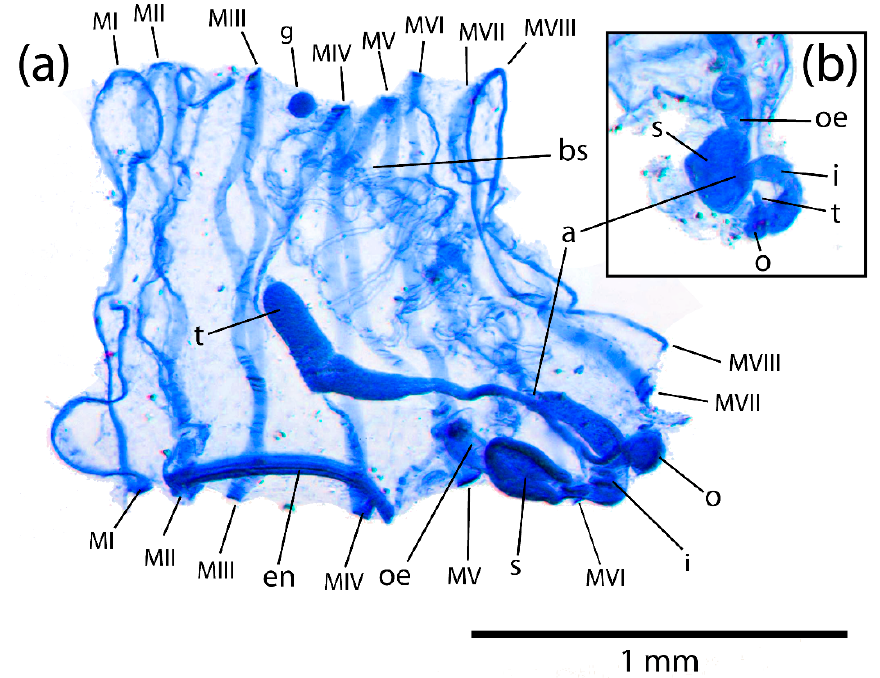
Figure 5. ( a ) Photograph of Janus Green B stained holotype of Dolioletta advena sp. nov. ( b ) Dorsal view of unrelated Janus Green B stained individual of D. advena sp. nov. which was dissected so that digestive system is exposed. MI to MVIII—muscle bands, en—endostyle, g—ganglion, t—testis,